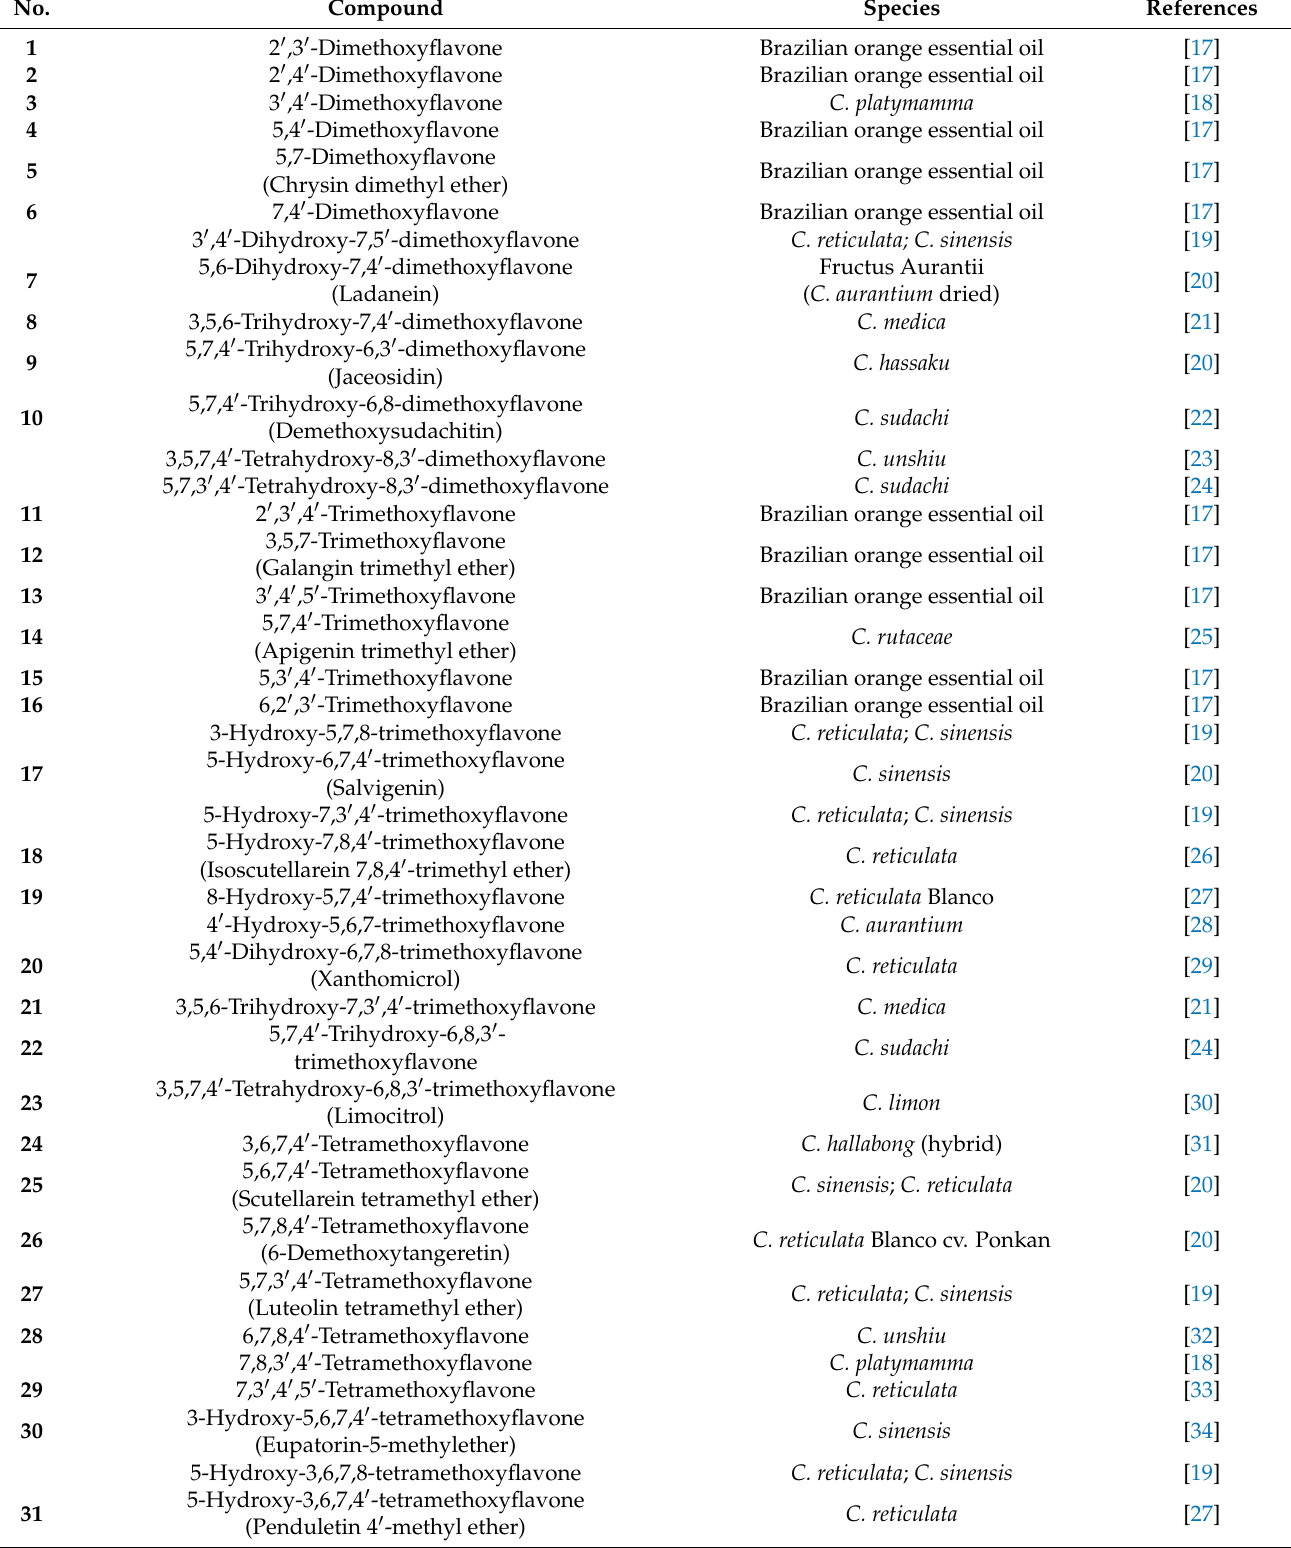
Table 1. Polymethoxyflavones identified in the genus Citrus